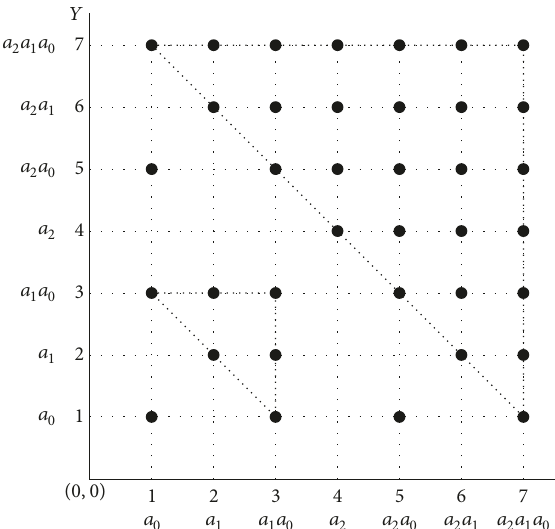
𝑓 = 𝑎 𝑎 + 𝑎 ¬𝑎 𝑎 0 1 0 1 2